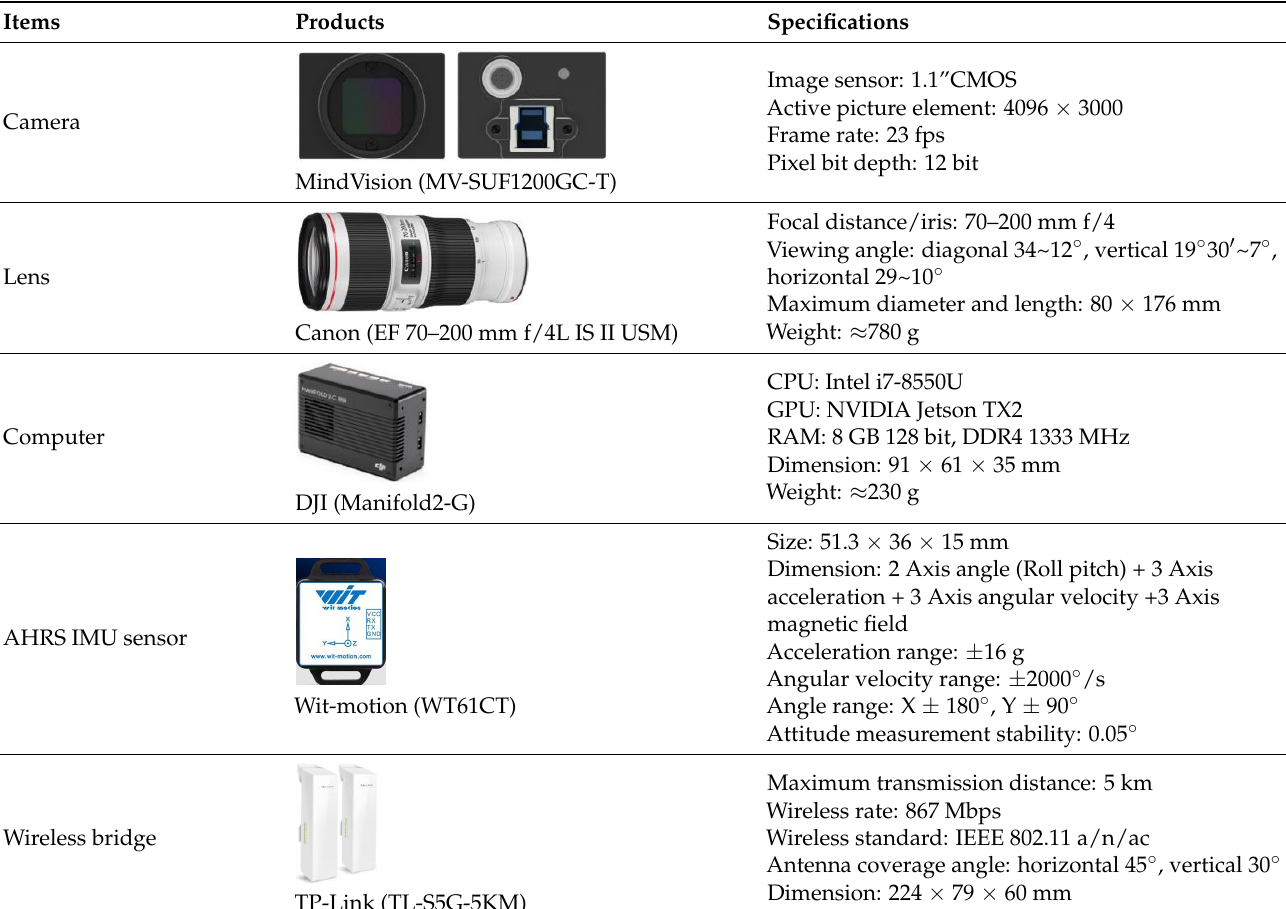
Figure 18. Photos of on-site installation of the optical targets and the camera. Table 4. Specifications of the main hardware.